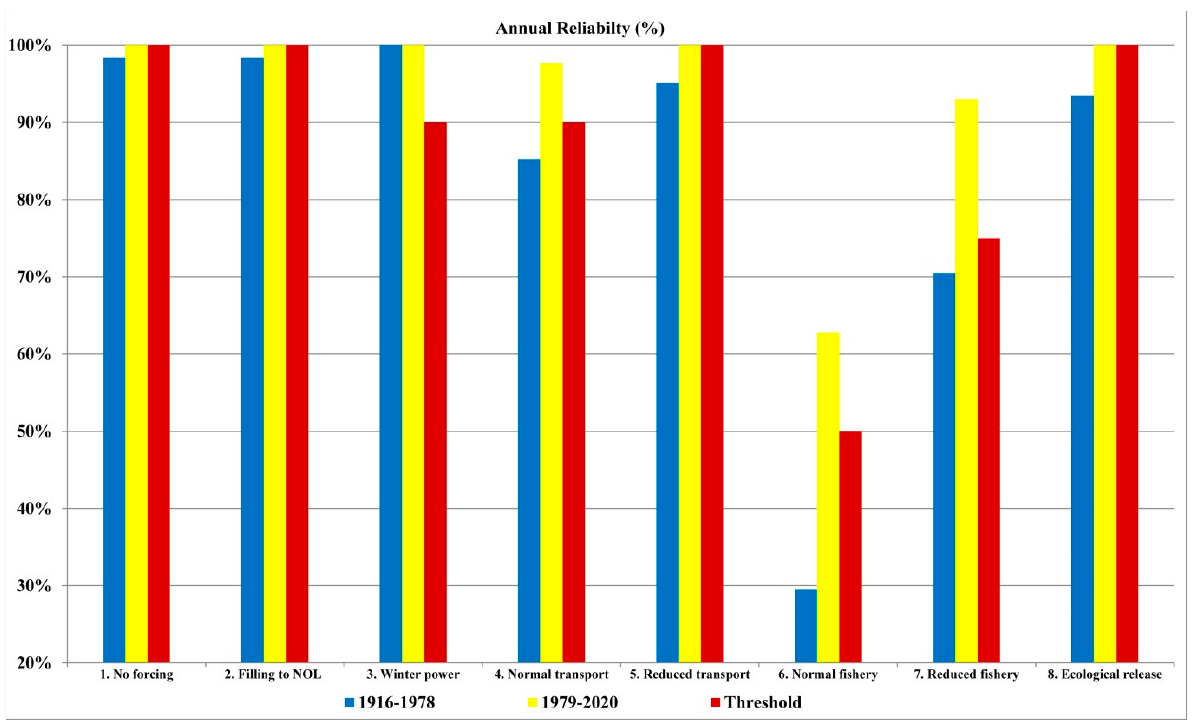
Figure 11. Reliability of the water user requirements for in fl ow series 1916–1978 and 1979–2020.